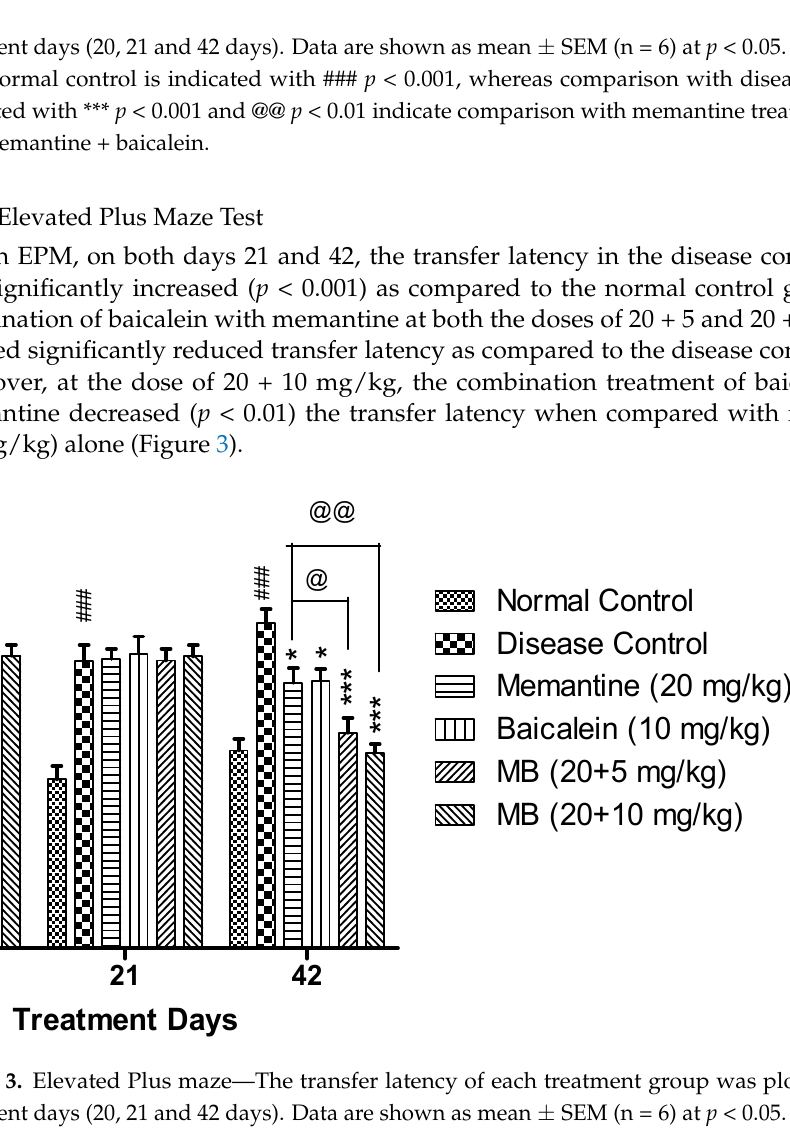
Figure 2. Morris water maze—The escape latency of each treatment group was plotted against treat- ment days (20, 21 and 42 days). Data are shown as mean ± SEM (n = 6) at p < 0.05. Comparison with normal control is indicated with ### p < 0.001, whereas comparison with disease control is indicated with *** p < 0.001 and @@ p < 0.01 indicate comparison with memantine treatment group. MB: memantine + baicalein.